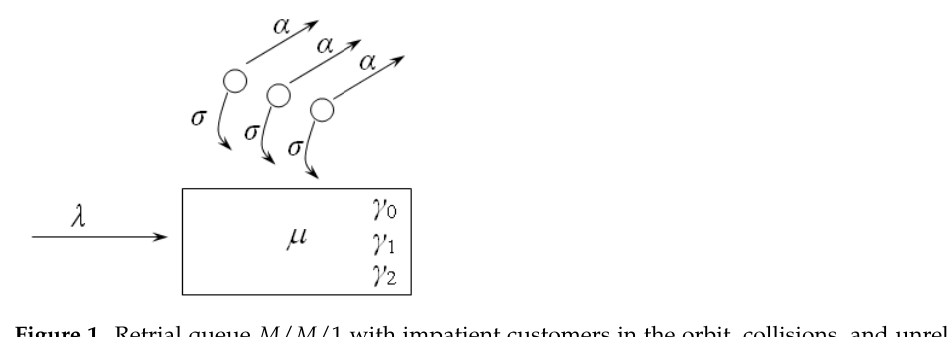
Figure 1. Retrial queue M / M /1 with impatient customers in the orbit, collisions, and unreliable